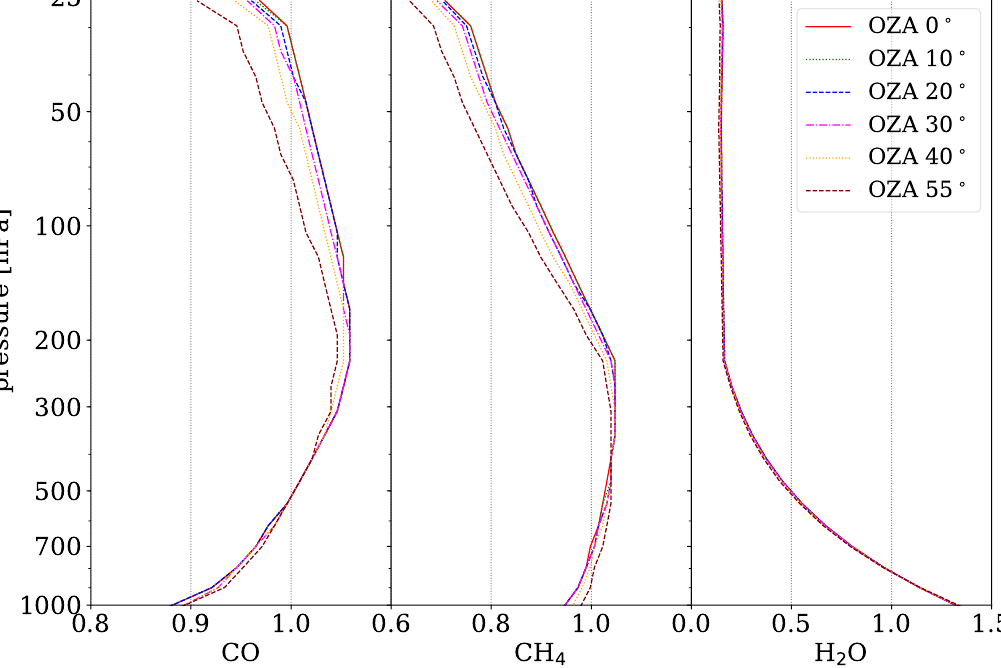
Figure 7. Altitude sensitivity of the CO retrieval in the 4277.20–4302.90 cm − 1 spectral range. The column averaging kernels (CAKs) were calculated for different TROPOMI observer zenith angles (OZAs) with a solar zenith angle (SZA) of 30 ◦ and a surface albedo of r 0 =